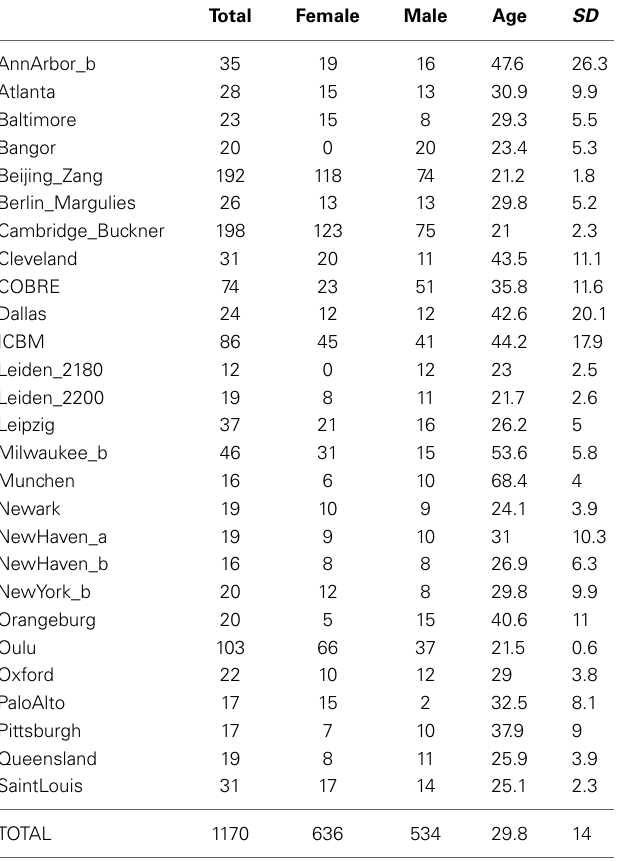
Table 1 | Overview on studies and number of subjects included in the analysis.